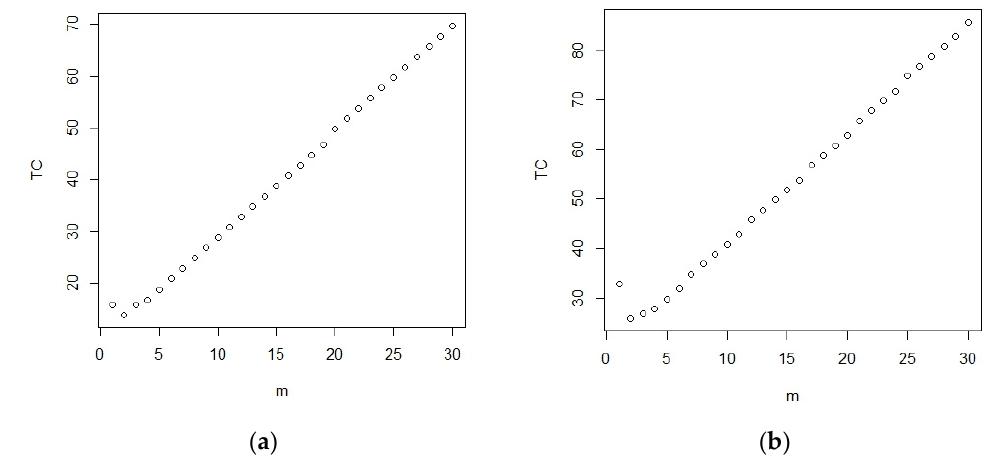
Figure 2. ( a ): Total cost curve at m = 1: m 0 . ( b ) Total cost curve at m = 1: m 0 . ≤ CH , the required minimal inspection intervals m* and the re- For testing 80.0: 0 L lated sample size n* to yield the minimum total cost TC ( m* ) with m < 50 are tabulated in β = 0.25, 0.20, 0.15, p = 0.01, Tables A1 and A2 at the conditions of α = 0.01, 0.05, 0.1, 0.025, 0.05, 0.15, 0.25 for c 1 = 0.825, 0.85 and c 1 = 0.875, 0.90 respectively. Tables A1 and A2 also contain the relevant critical values.